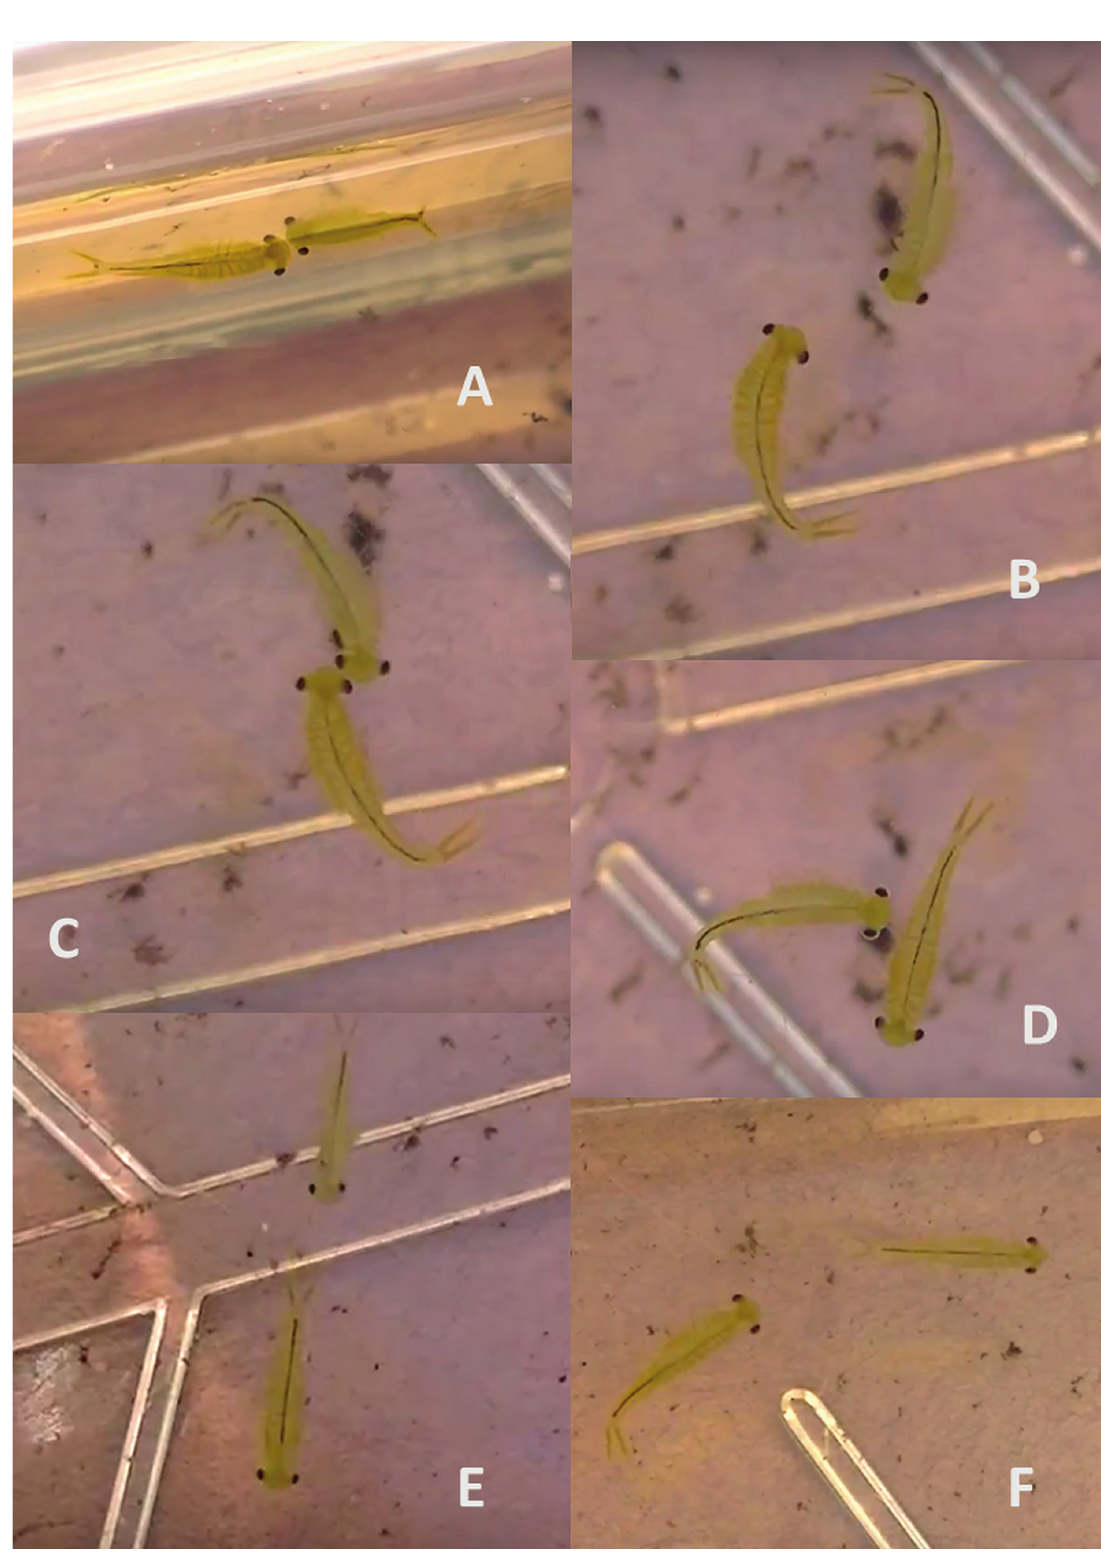
Fig. 3. Dendrocephalus proeliator sp. nov, male-male aggressive interactions. A. Encounter. B. Circling. C. Head to head attack. D. Broadside attack. E–F.